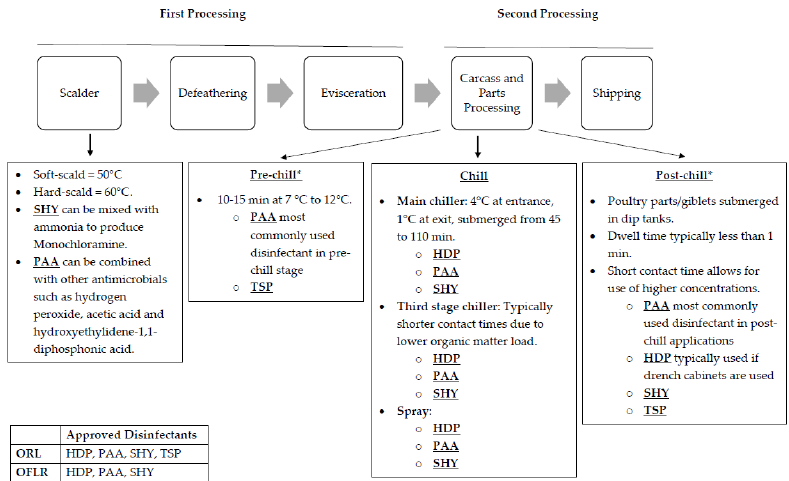
Figure 1. A general schematic overview of commercial poultry processing. The information provided serves as an example of possible scenarios. However, protocols can vary widely among processing plants. In addition, the list of antimicrobials approved for on-line reprocessing (OLR) and off-line reprocessing (OFLR) is dynamic in terms of application and concentration. * At a minimum, sampling for pathogens must occur at the pre- and post-chill points.